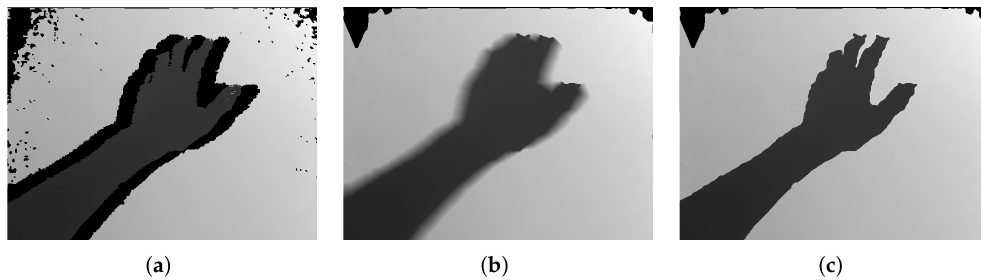
Figure 11. Closer depth area refinement results: ( a ) input depth image; ( b ) result without refinement; and ( c ) result with